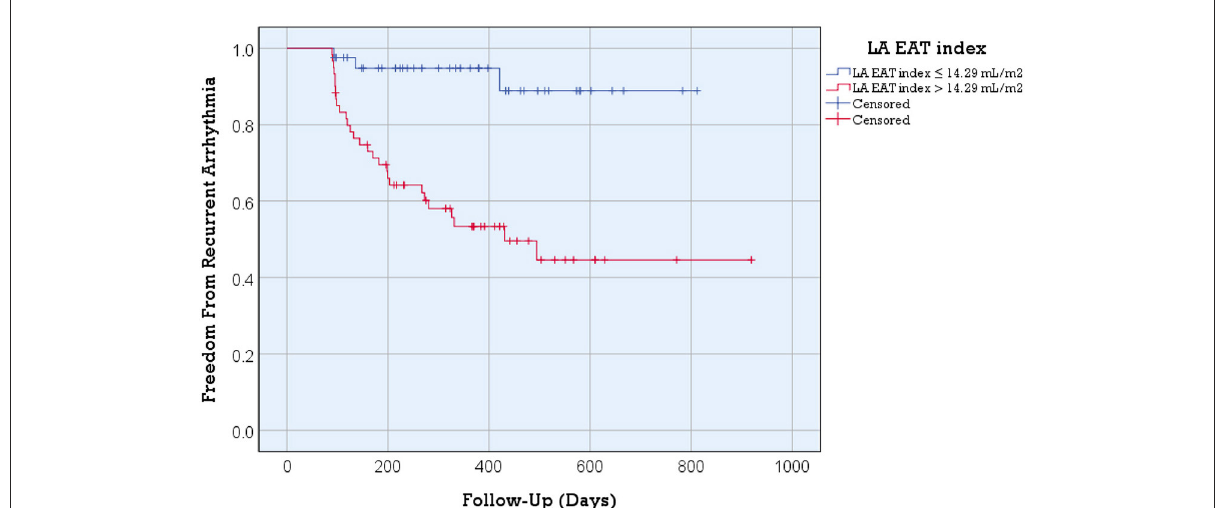
FIGURE3 Kaplan-Meier arrhythmia free survival analysis for post ablation AF recurrence according to the LA EAT index. Better arrhythmia free survival was detected in patients with an LA EAT index ≤ 14.29 mL/m 2 (log rank = 14.79; p -value < 0.001). Recurrent arrhythmia was observed in 7.3% of patients with an LA EAT index > 14.29 mL/m 2 compared to 46.7% of patients with an LA EAT index > 14.29 mL/m 2 ( p -value <